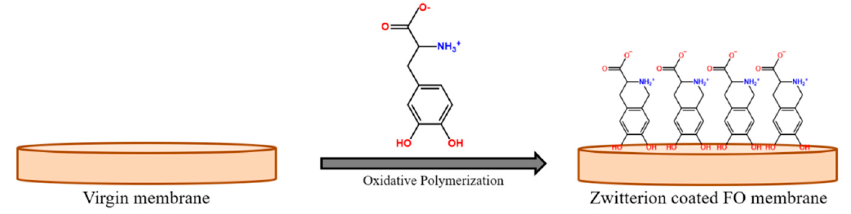
Figure 5. The schematic of formation of zwitterionic polymer coated FO membrane [78]